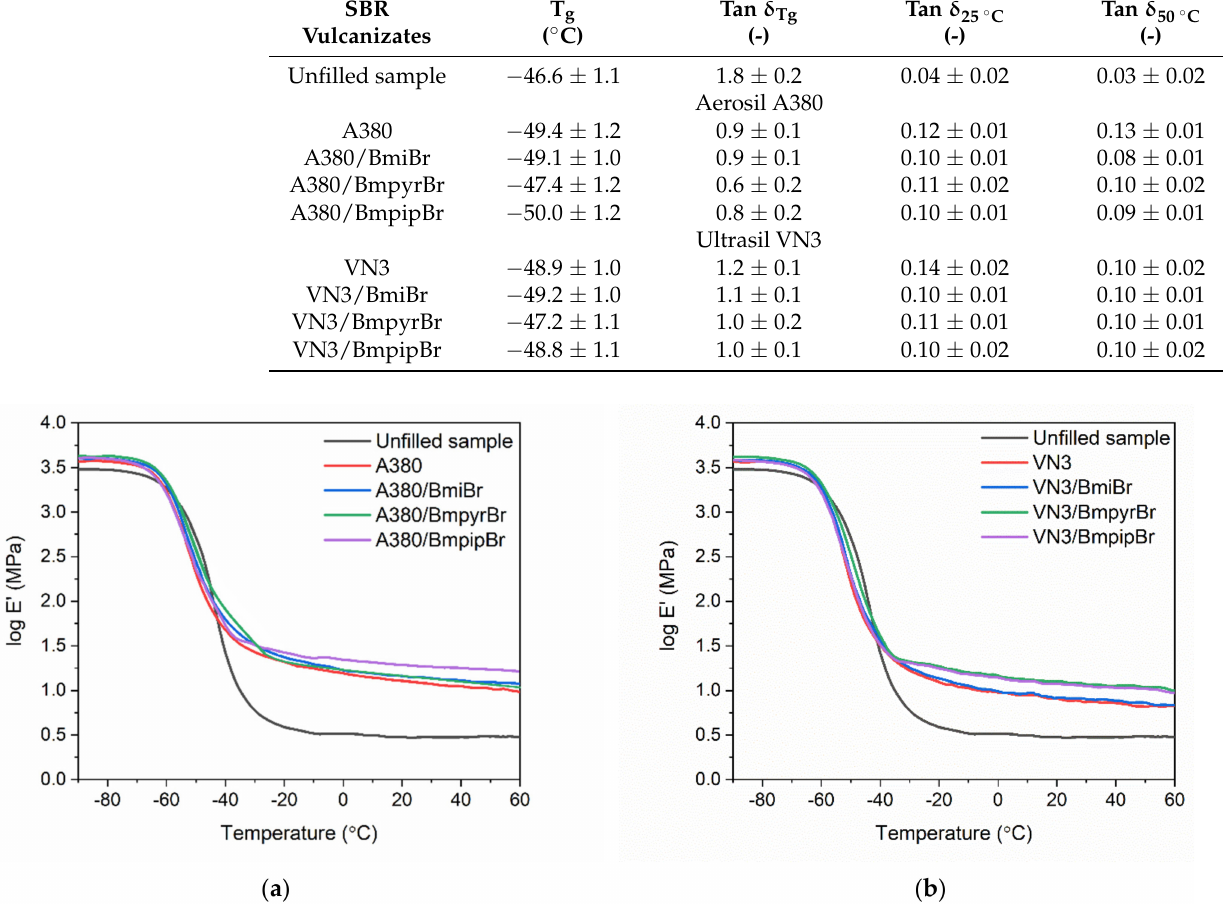
Figure 10. Storage modulus (E’) curves versus temperature of SBR composites filled with silica: ( a ) A380; ( b )